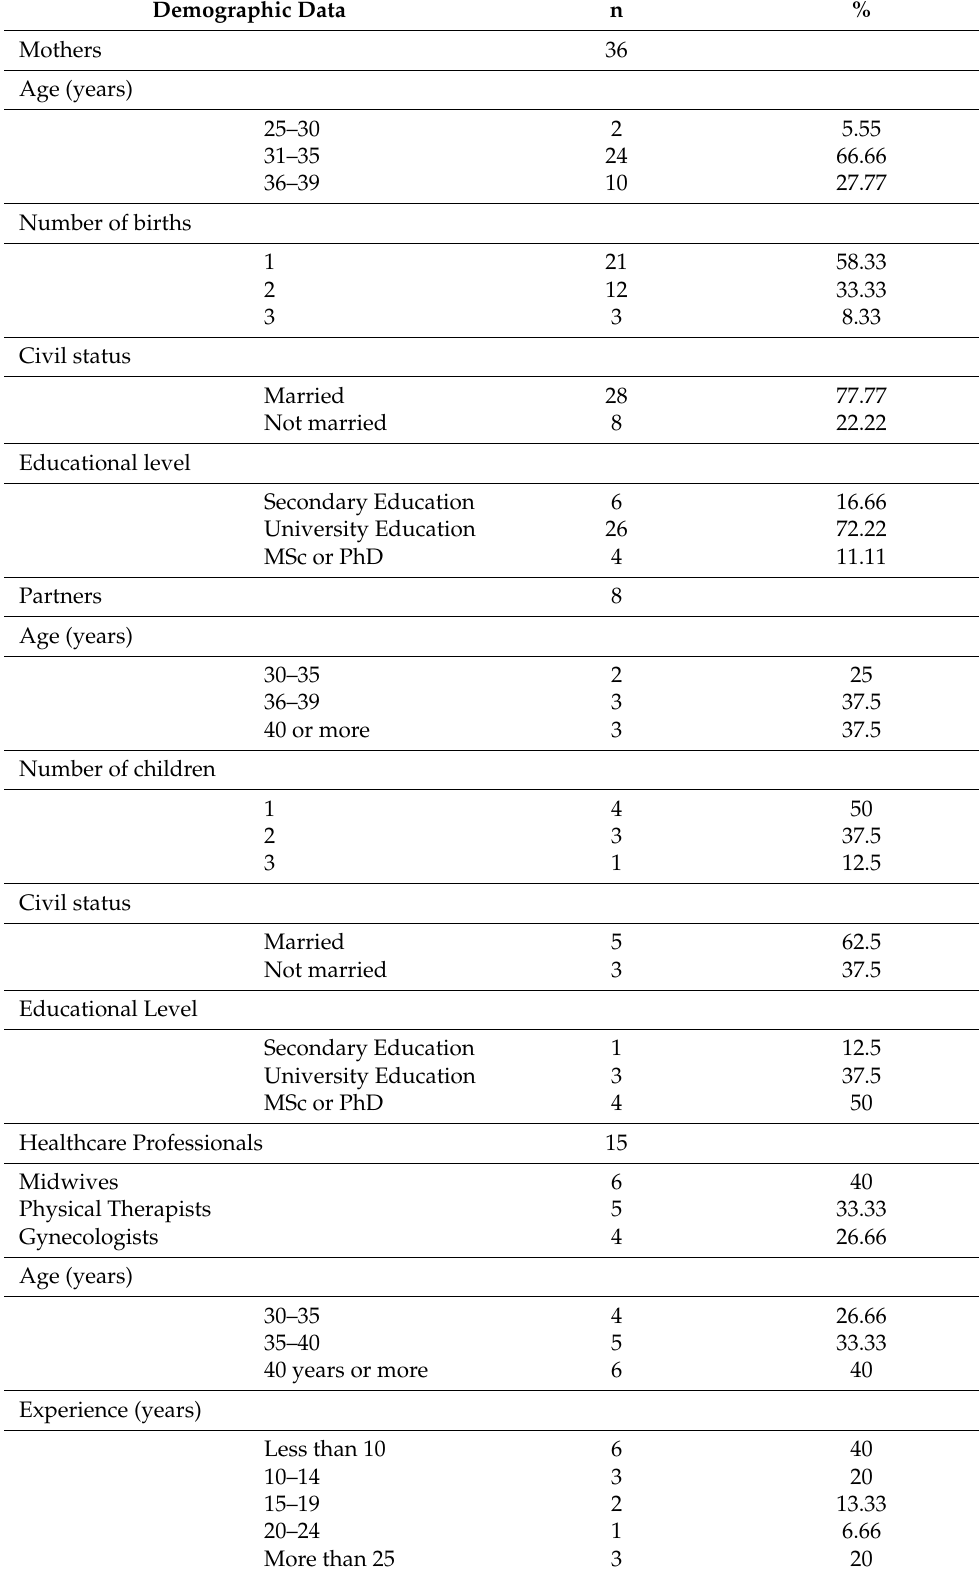
Table 2. Demographic